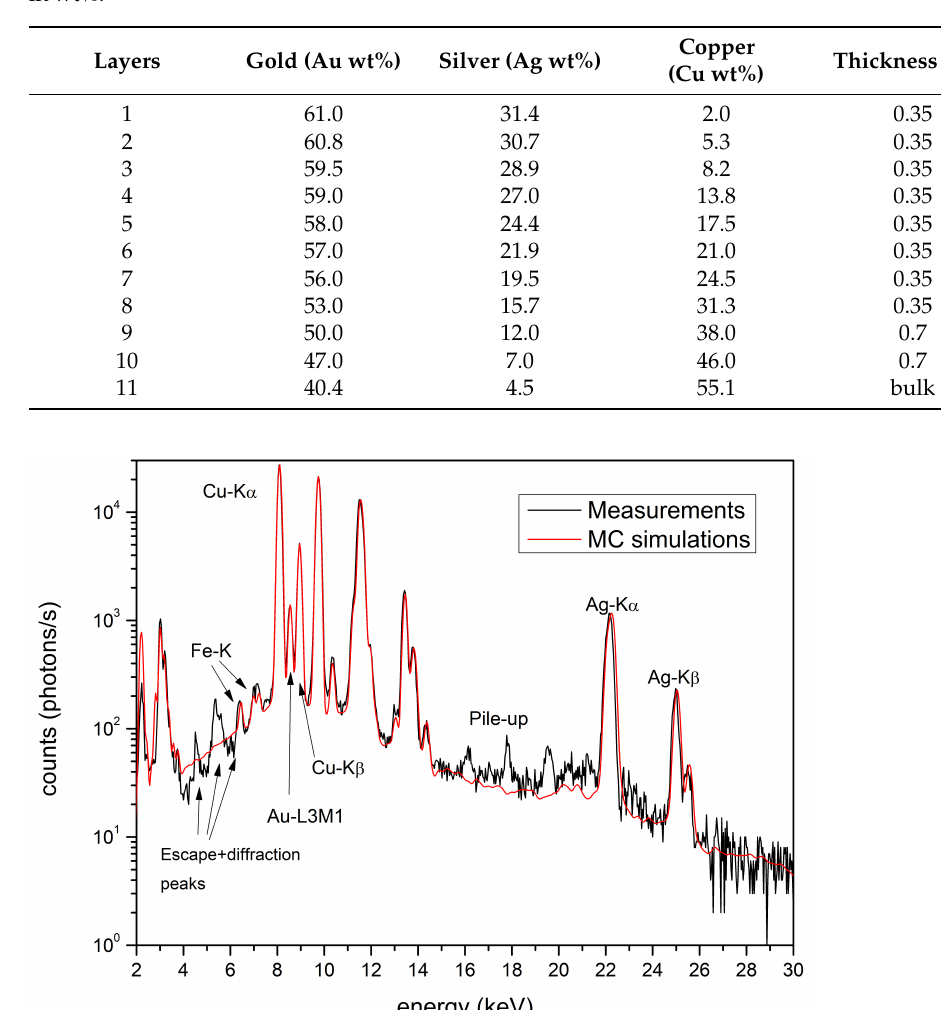
Figure 7. Chin protector. Comparison between MCS and XRF measured spectra. The unfitted peaks are due to pile-up, escape and diffraction phenomena and so not